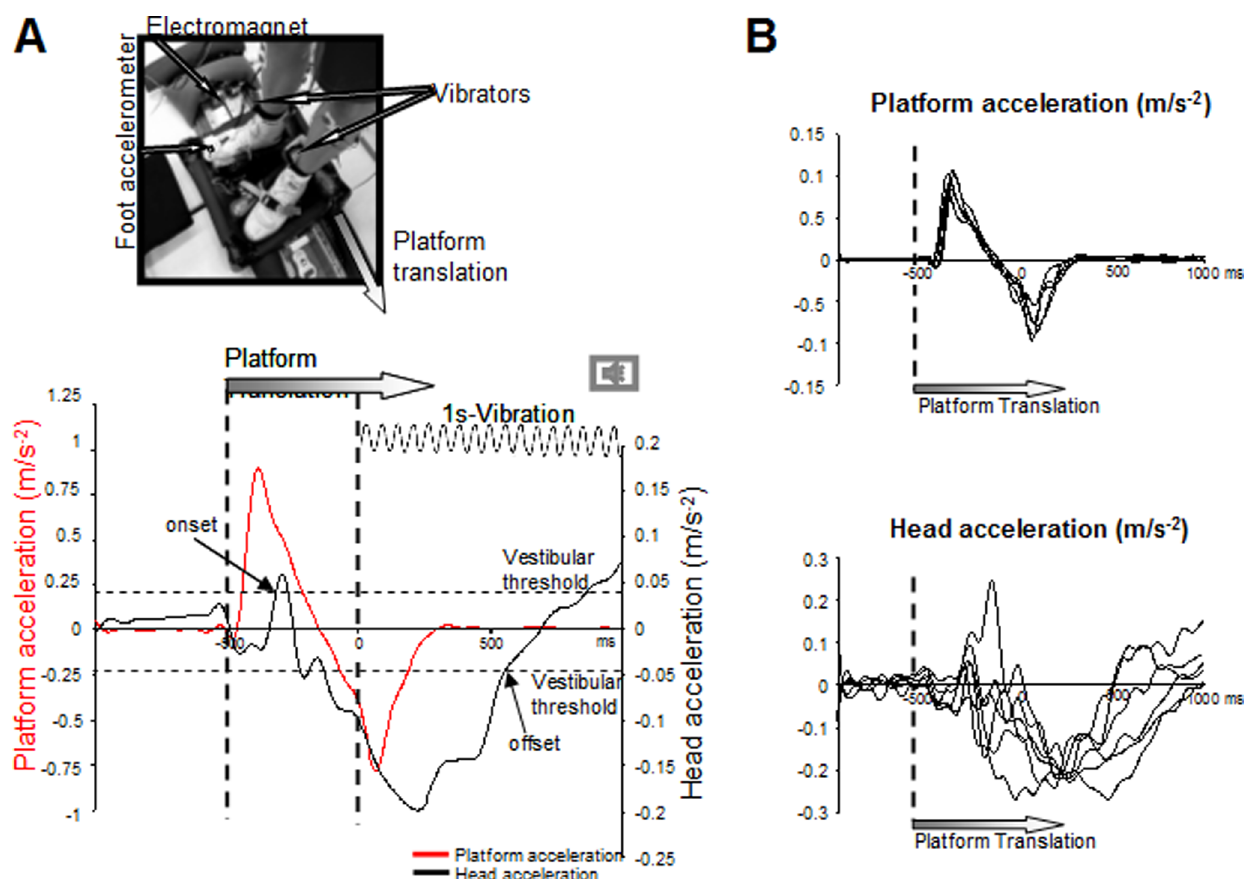
Figure 1. Experimental set-up and mean lateral platform acceleration (left scale and red curve) and head acceleration (right scale and black curve) during Translation standing condition for the 6 participants. The onset and offset of head acceleration and deceleration, respectively, were indicated by the arrows according to the vestibular threshold (horizontal dotted lines). B: Mean platform and head accelerations for each of the 6 participants.